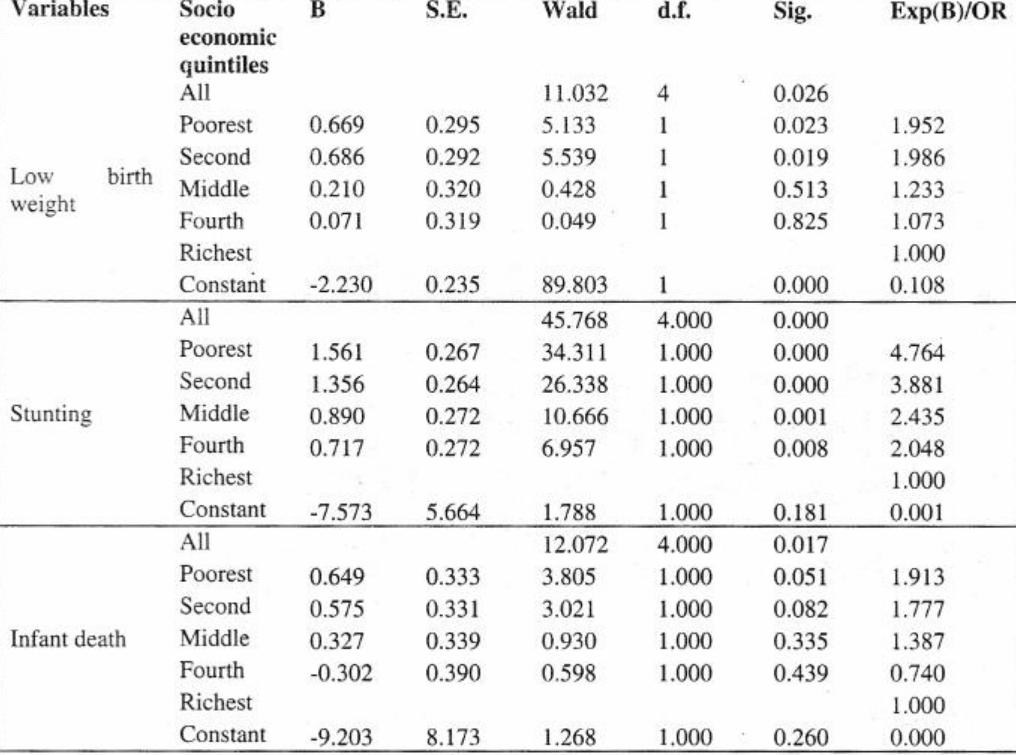
Table 5 Summeryof Regressionstatistics showing association between Socio economic quintiles and having a low birth weight child, being an underweight child and dying before age of 5 years